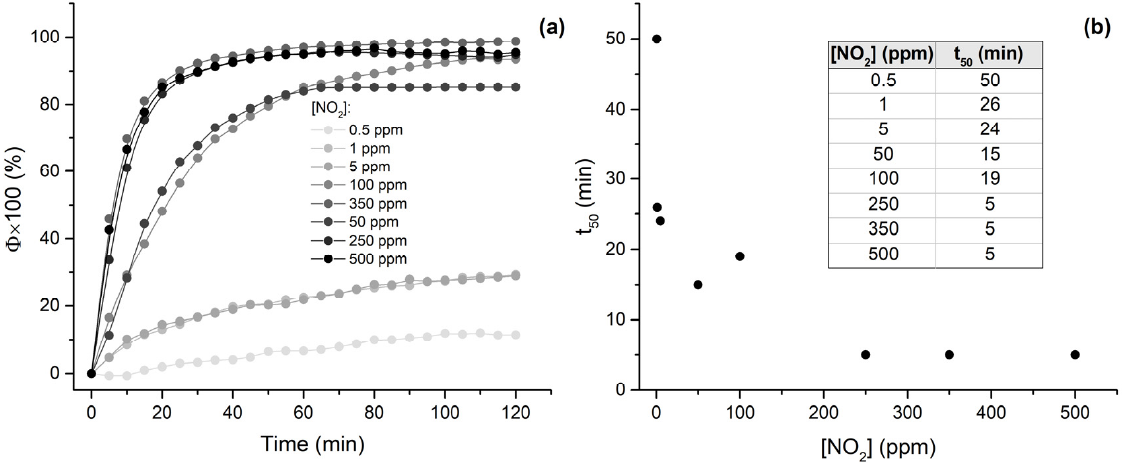
Figure 8. ( a ) Kinetic response of TCPC@MOF@PDMS under exposure to 0.5–500 ppm NO 2 gas and ( b ) the corresponding t 50 values for this analyte concentration range.